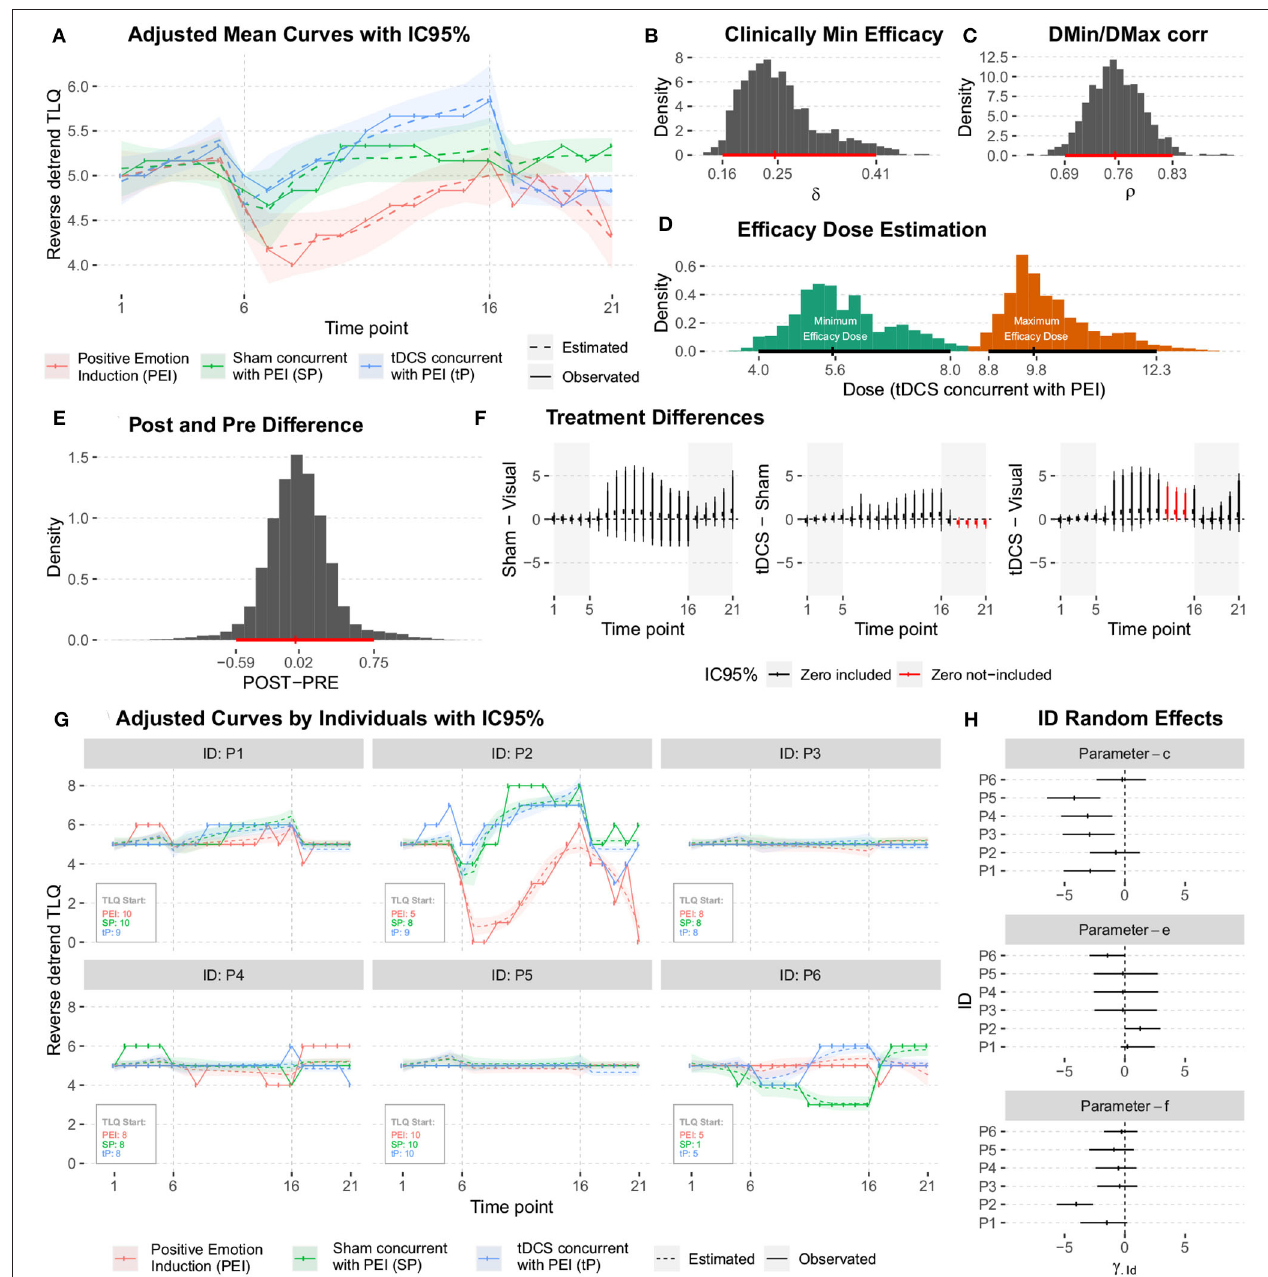
FIGURE 10 | (A) Graphical summary for the mean curve, showing the adjusted and observed behaviors. (B) The posteriori distribution of the Minimum Clinical Efficacy ( δ ). (C) The posteriori distribution of the correlation between µ DMin and µ DMax . (D) The posteriori distributions of the minimum and maximum effective doses. (E) The posteriori distribution for the difference between the average responses during the POST ( T 21 ) and PRE ( T 1 ) periods. (F) The posterior distributions of the difference between treatments (conditioned to the time point). (G) The mean curve dynamics considering the individual random effects predictions. (H) The posteriori distributions for the predictions were obtained for ID random